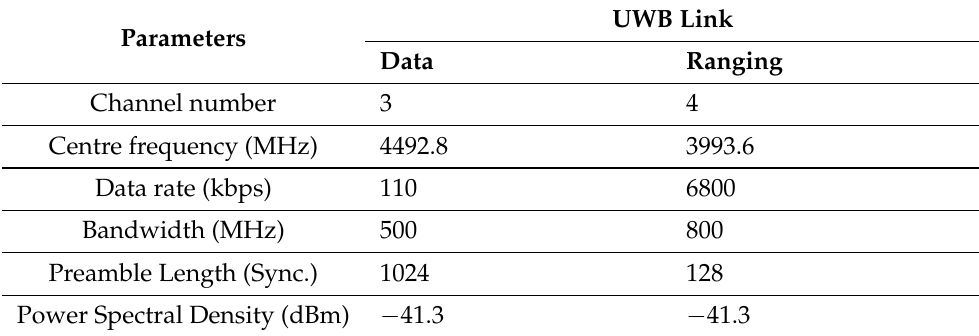
Table 2. UWB links in the WATEREYE system architecture.